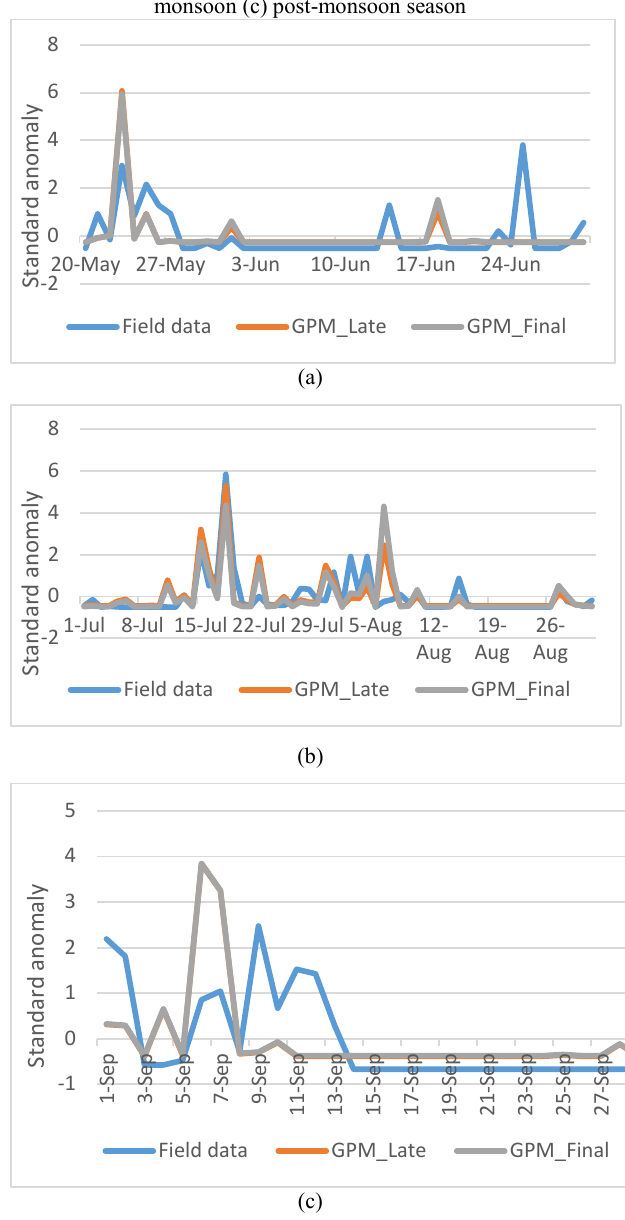
Figure 4. Comparison of NIH field data with GPM-IMERG late and final run precipitation data for 2015 (a) pre-monsoon (b)